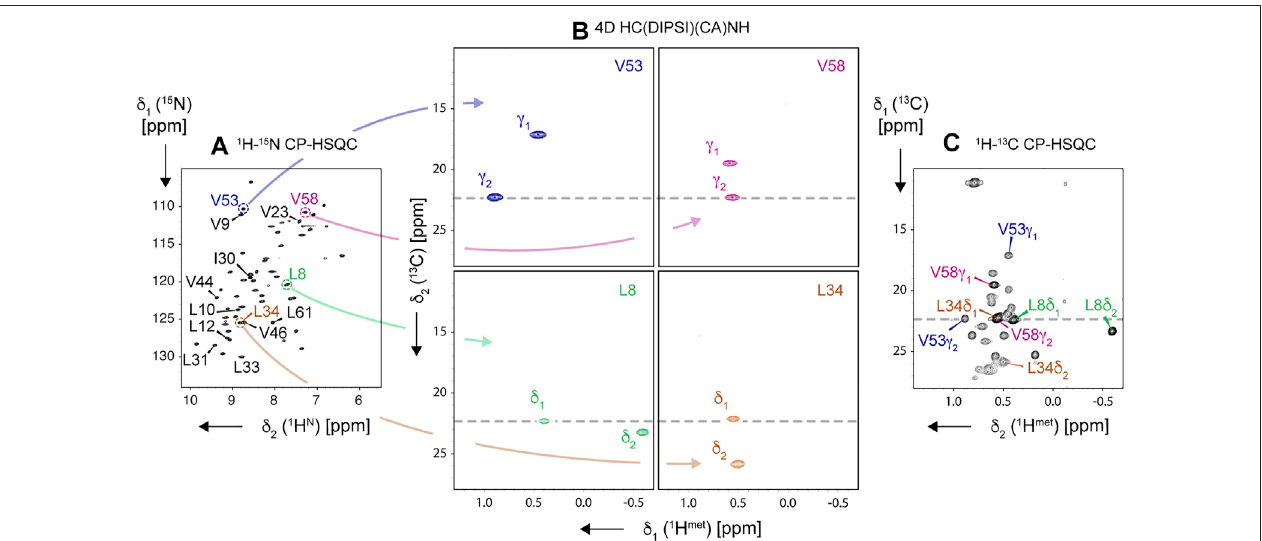
FIGURE 13 | Resolving ambiguity of methyl 1 H and 13 C resonance assignment using 4D HC(DIPSI)(CA)NH experiment, demonstrated on the “ ILV-C4 ” sample of SH3 protein, spun at 94.5 kHz on an 18.8-T spectrometer. Navigation in the 4D spectral matrix is based on peak positions in 2D 1 H, 15 N-CP-HSQC (A) , allowing to display intraresiduepairs ofcorrelationsin 1 H, 13 C-cross sections ofthe4Dcube (B) .Obtained methyl resonance assignmentsforfour representative residues (L8,L34, V53,and V58,color-coded) arereadilytransferableto2D 1 H, 13 C-CP-HSQCspectrum (C) .In (A) ,amidecorrelationsofallLeu,Val, andIle residues arelabeled.All correlations except for residue Val-46 were observed in the 4D